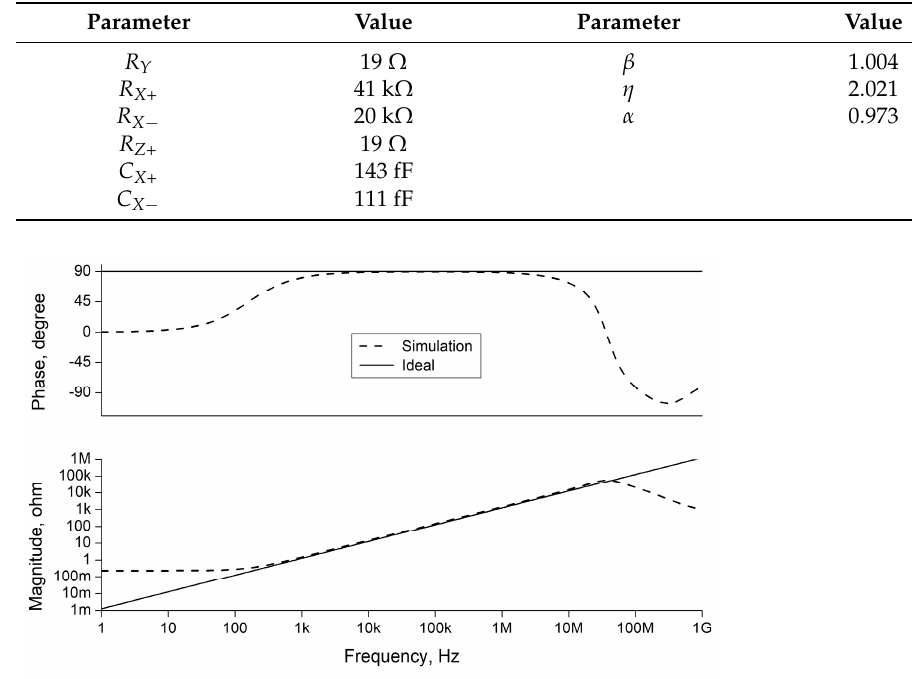
Figure 5. Internal structure of the used VCII± without Z − terminal. Table 1. Some performance parameters of the VCII ± of Figure 5.